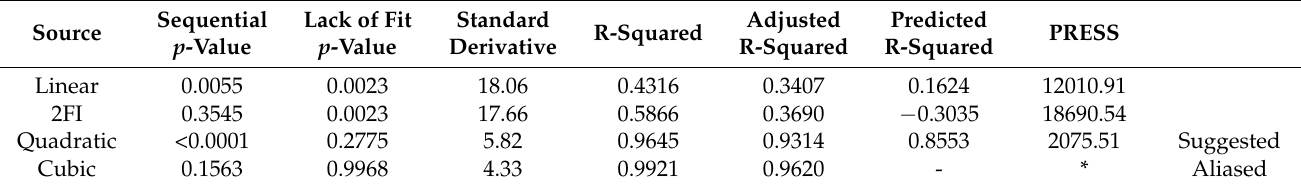
Figure 10. Typical XRD patterns (experimental pattern) before and after the ion exchange process. 2.9. RSM and Model Fit for Cu(II) Removal onto H + Dowex-M4195 Chelating Resin Thirty observed responses of q e (mg/g) were obtained from the design RSM-CCD ma- trix (non-center point 24 and center point 6). Obtained q e responses were utilized to generate the empirical model terms using RSM to formulate the model summary statistics for Cu(II) loaded onto H + Dowex-M4195 chelating resin. The adsorption capacity/removal capability ( q e (mg/g)) of H + Dowex-M4195 chelating resin was investigated as a quadratic model computed using software. We focused on the model with the highest R-squared value, adjusted R-squared or predicted R-squared and order polynomial where the additional terms are significant and the model is not aliased, as presented in Table 3. Table 3. Model summary statistics for Cu(II) loaded onto H + Dowex-M4195 chelating